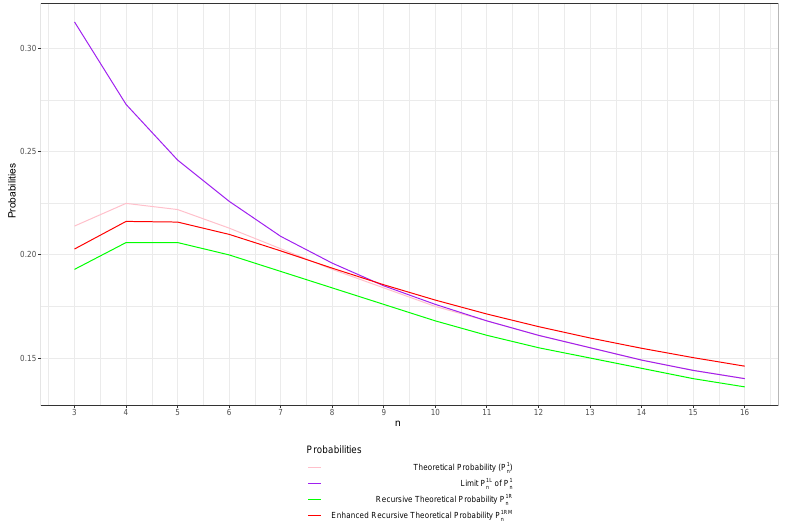
Figure 5. Comparison of the limiting probabilities P 1 L n and the recursive probabilities P 1 R n with the exact theoretical probabilities P 1 n